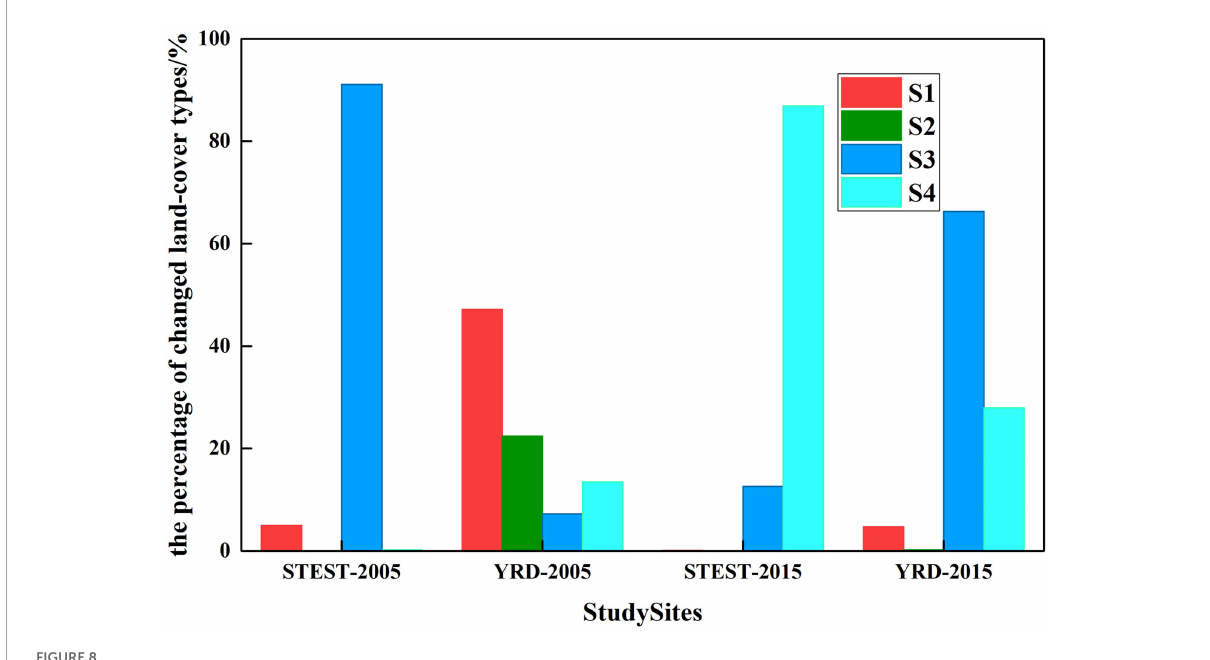
FIGURE8 The percentage of transferred land-cover types in the changing area.